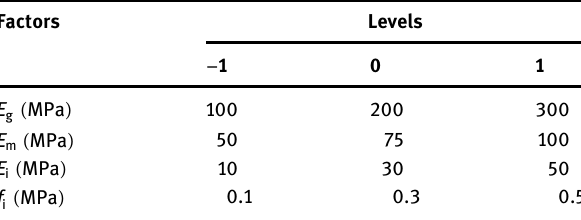
Table 1: Table of factor levels Factors